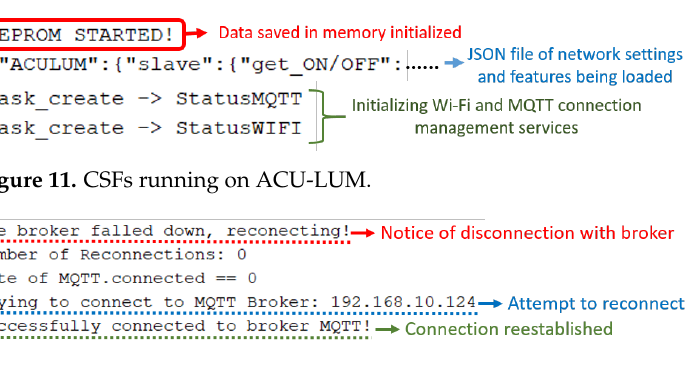
Figure 12. Attempt to reconnect ACU-LUM with MQTT